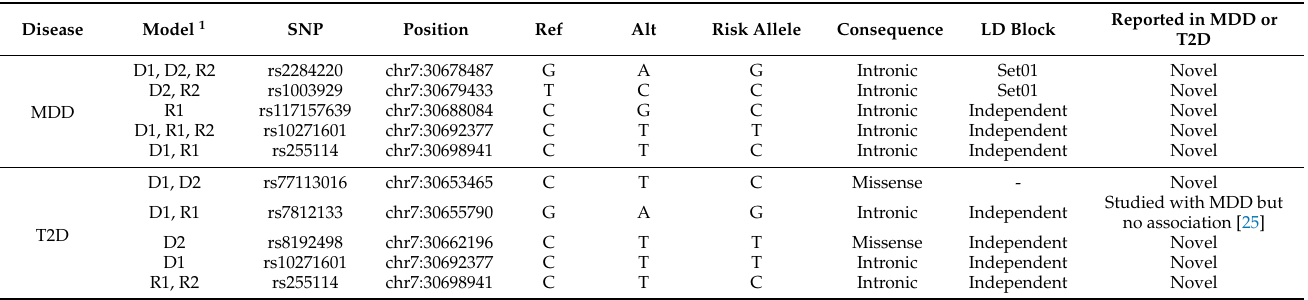
Table 1. CRHR2 -Risk Single Nucleotide Polymorphisms (SNPs) for Major Depressive Disorder (MDD) and Type 2 Diabetes (T2D).